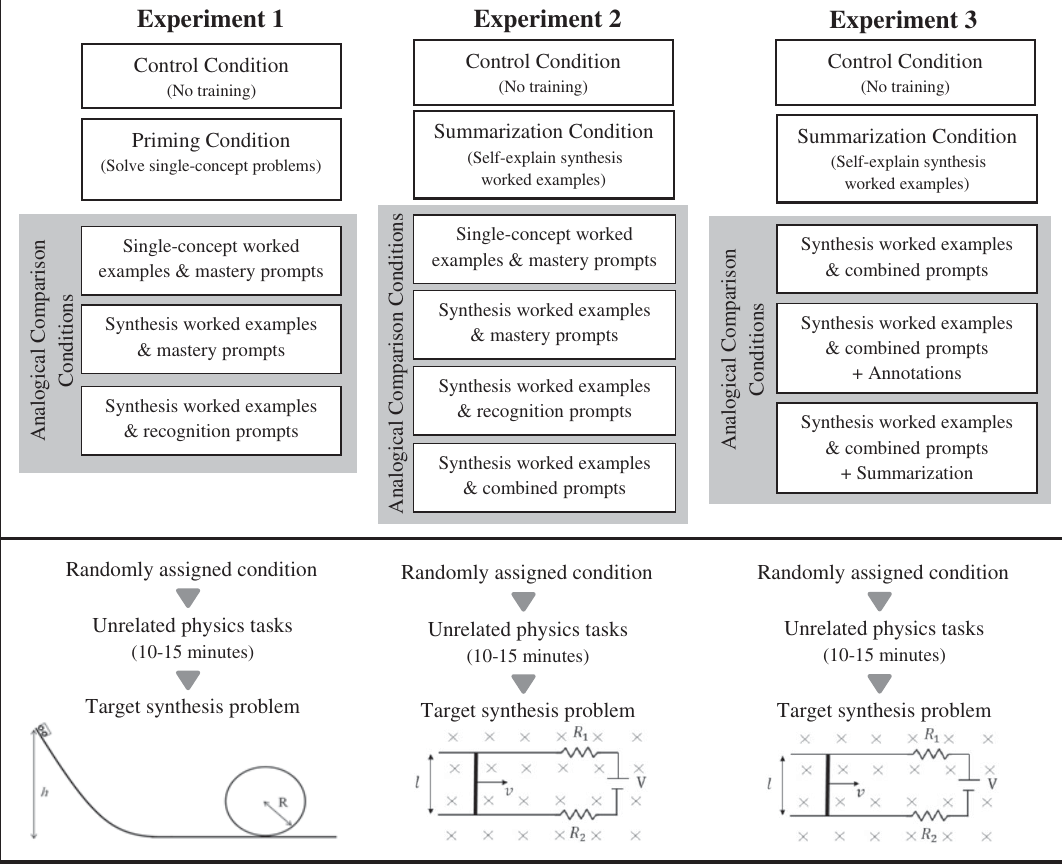
FIG. 1. The experimental design used in each of the three experiments. Experiments 2 and 3 used the same target synthesis